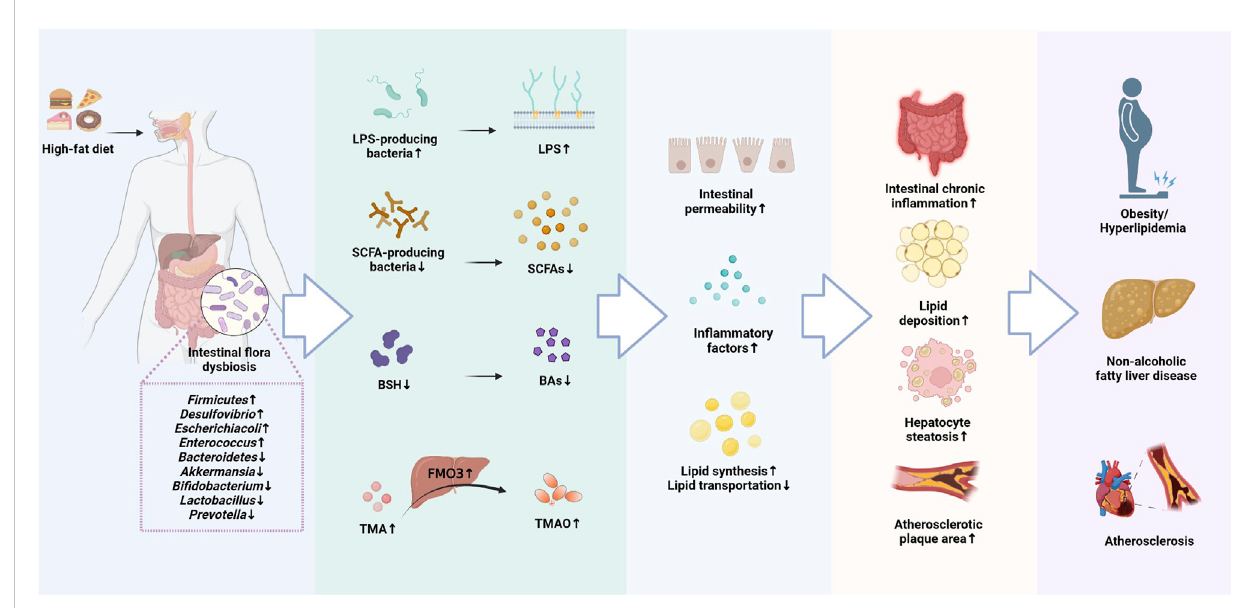
The molecular mechanisms of intestinal fl ora involved in the development of Lipid metabolism disorders